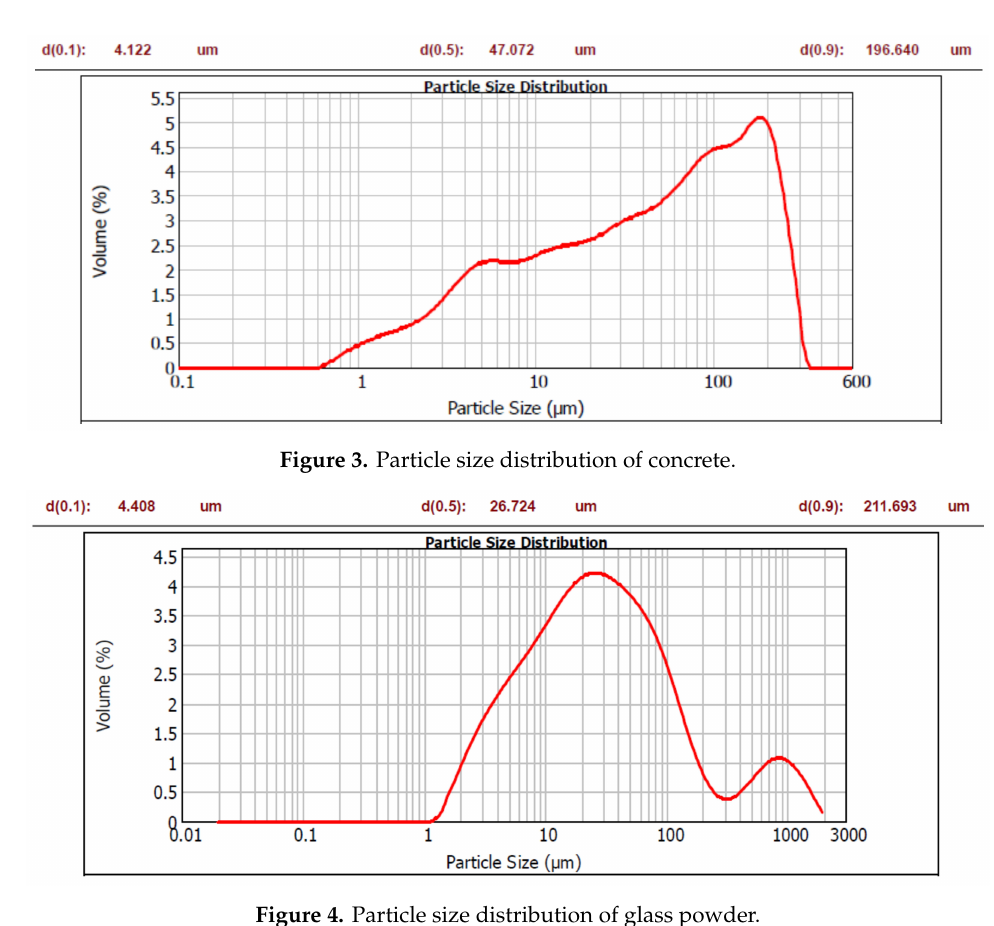
Figure 4. Particle size distribution of glass